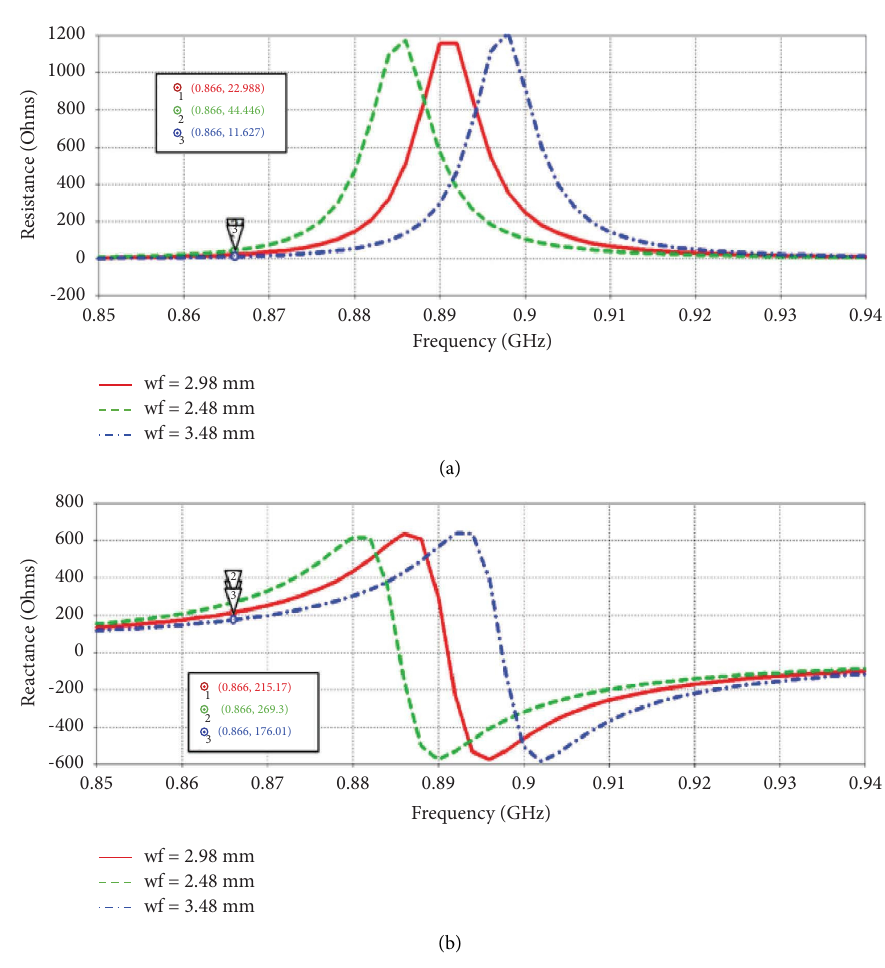
Figure 9: Tag’s (a) resistance and (b) reactance variation with varying “ w